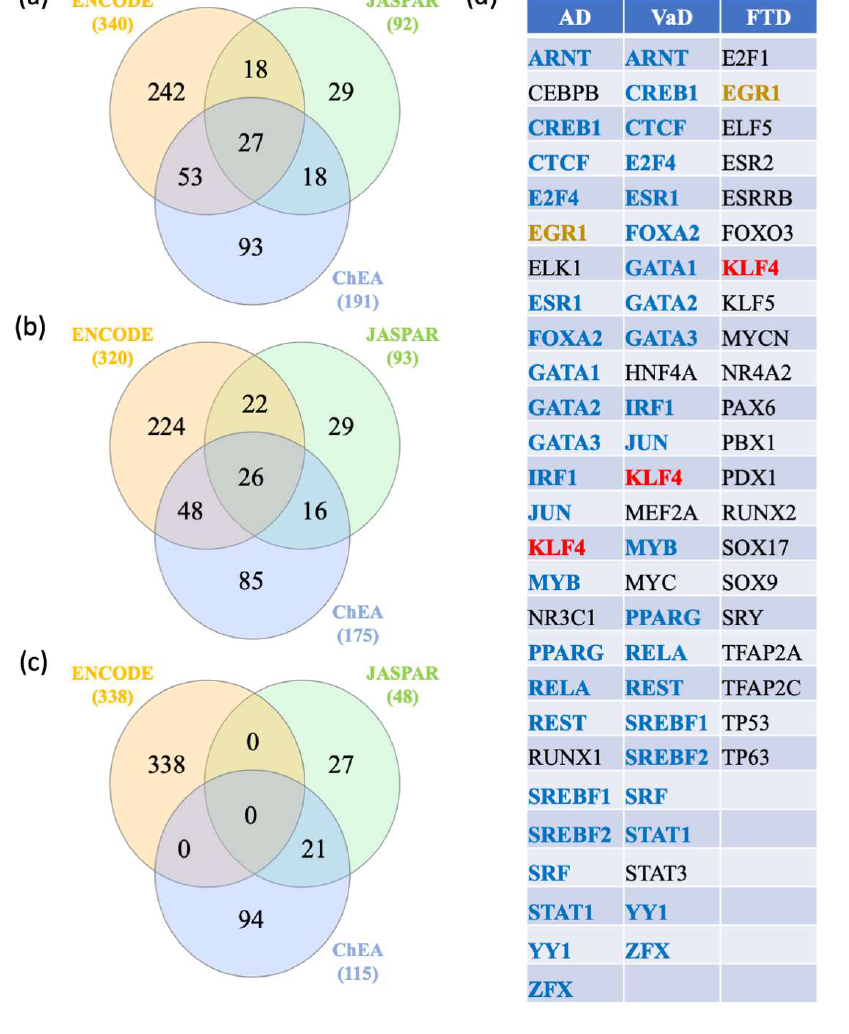
Figure 6. Transcription factors analysis. The AD, VaD, and FTD genes lists were uploaded to NetworkAnalyst, https://www.networkanalyst.ca/NetworkAnalyst/faces/home.xhtml. The gene-transcription factor interaction network was performed using ENCODE, ChEA, and JASPAR databases and ( a ), ( b ), and ( c ) represent the results of the Venn diagram analysis performed with AD, VaD and FTD genes, respectively. The transcription factors interacting with the AD, VaD, and FTD genes were listed in ( d ). The transcription factor in red is shared between the 3 types of dementia. The transcription factors in blue are shared between AD and VaD. The transcription factor in brown is shared between AD and FTD. The transcription factors in black are unique to each dementia